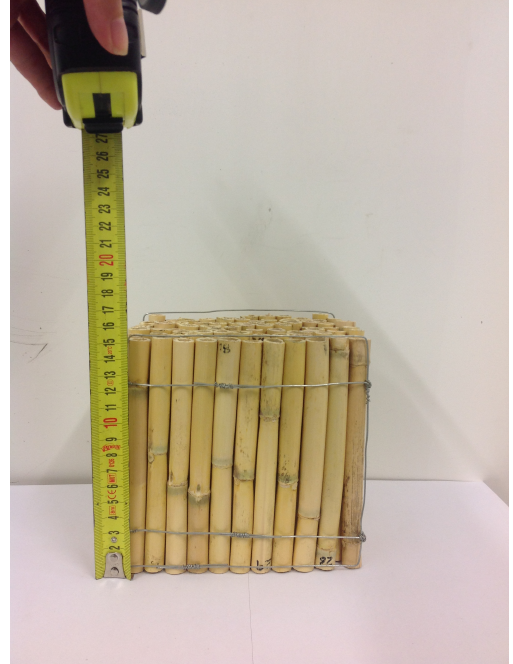
Figure 2. Reed board prototype.